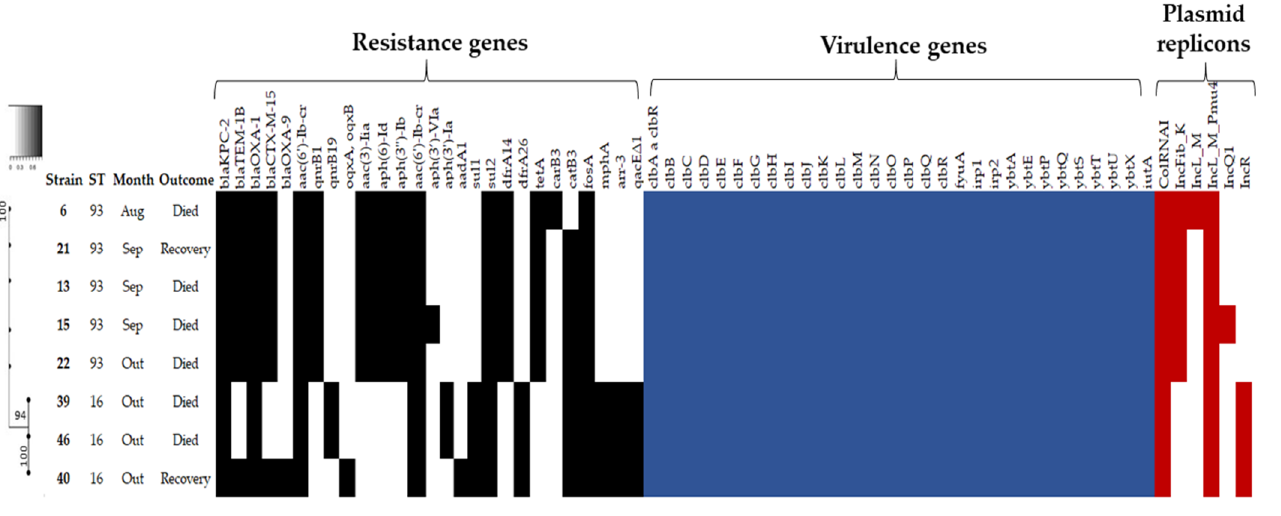
Figure 1. Maximum-likelihood phylogenetic tree and gene content of polymyxin-resistant K. aerogenes strains isolated from ICU. Black bars represent the presence of resistance genes, blue bars the virulence genes and red bars the plasmid profile, predicted by the ResFinder 4.1 program.